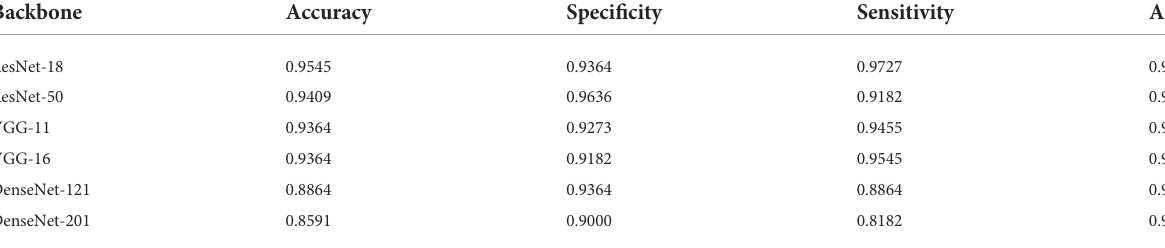
TABLE 3 Performance of the proposed network with different